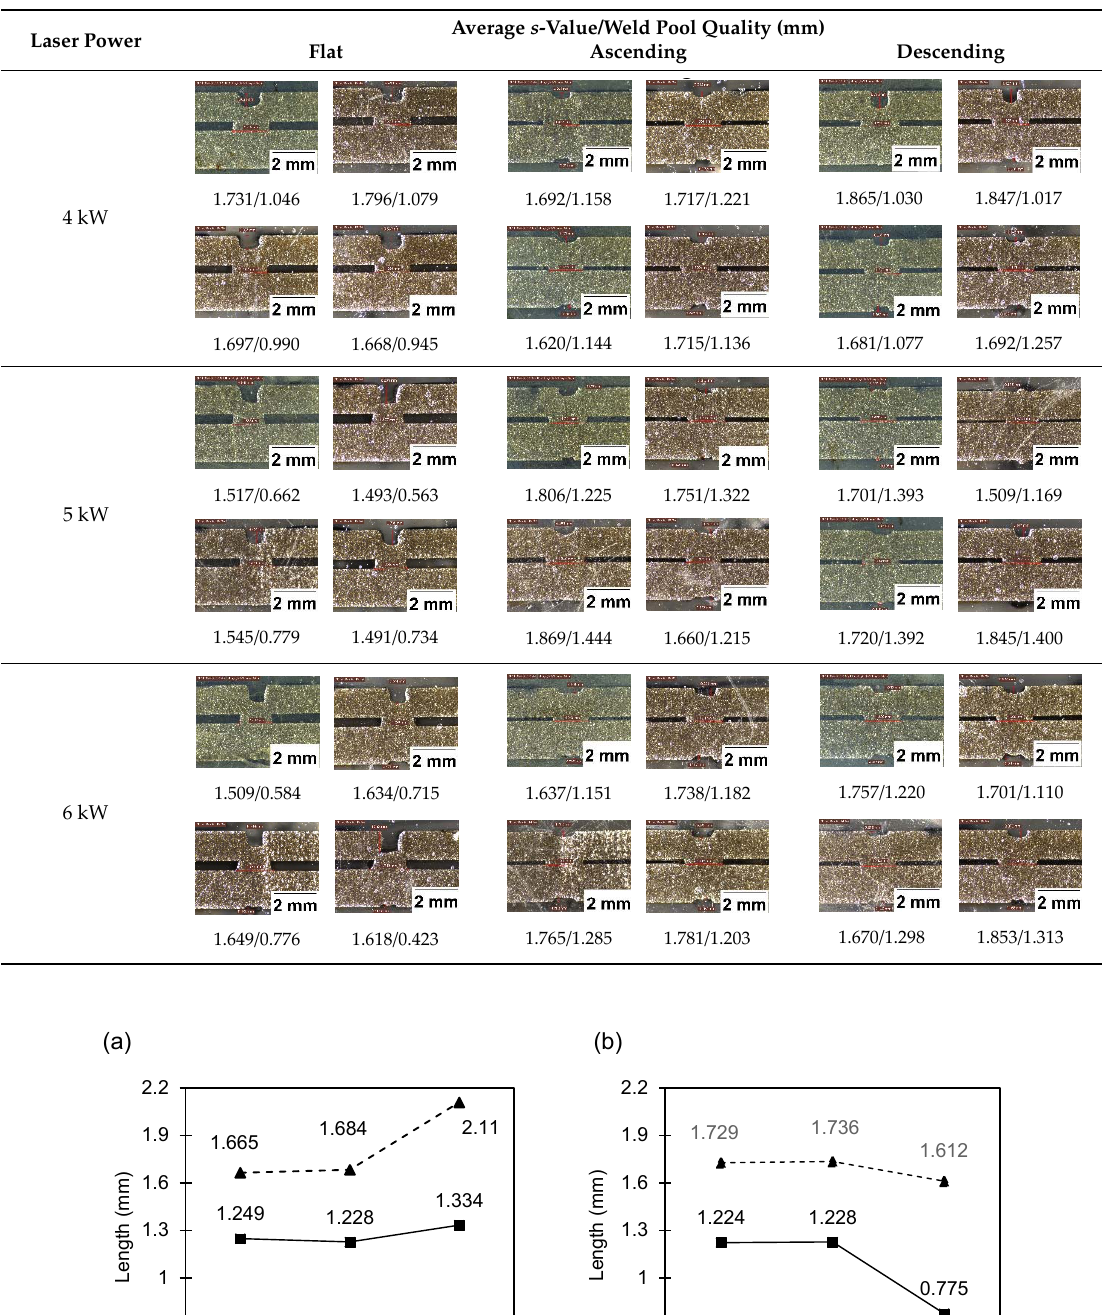
Table 12. ANOVA table of the s ‐ value for experiment #2 ‐ 1 (2 ‐ kW fiber laser welding system).